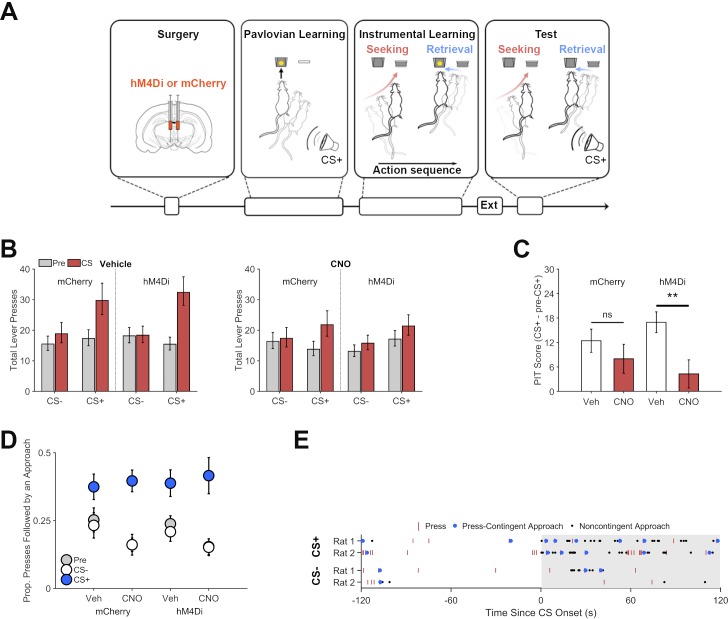
Chemogenetic inhibition of dopamine neurons on Pavlovian to instrumental transfer (PIT) performance.(A) Experimental design: Following viral vectors injections and recovery, rats received Pavlovian training, during which they learned to associate an auditory cue (CS+) with food pellet delivery. During instrumental conditioning, rats performed the same lever-press task used in Experiment 1. Lever pressing was extinguished (Ext) before rats were submitted to a PIT test, which included separate noncontingent presentations of the CS+ and an unpaired control cue (CS-). (B) Chemogenetic inhibition of VTA dopamine neurons disrupted cue-motivated reward seeking. Total lever presses during PIT trials for rats expressing the inhibitory DREADD hM4Di or mCherry following vehicle (left) or CNO (5 mg/kg, right) treatment prior to test. Presses during pre-CS (gray) and CS periods (red) are plotted separately. (C) PIT expression is specifically impaired in hM4Di expressing Th:Cre+ rats. PIT scores (total presses: CS+ - pre-CS+) show that the CS+ increased lever pressing after vehicle treatment for both groups, but that CNO suppressed this effect in the hM4Di group but not the mCherry group. **p<0.01. (D) The CS+ increased the proportion of lever presses that were followed by a food-cup approach during PIT testing. Inhibiting VTA dopamine neurons did not disrupt expression of this effect. Instead, rats in both groups showed a modest increase in their likelihood of checking the food cup after lever pressing when treated with CNO. (E) Representative organization of the effects of the CS+ and CS- on attempts to seek out and retrieve reward during PIT. Data show lever presses and food-cup approaches (press-contingent or noncontingent) for two control rats (Th:Cre+ rats expressing mCherry and receiving vehicle).10.7554/eLife.43551.009Figure 3—source data 1.This spreadsheet contains the behavioral responses for individual rats in Figure 3.